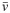
Fitted parameters over the range q = 0-0.4 μm−1.(a) Mean v¯ and (b) width σ of the fitted Schultz swimming speed distribution, (c) proportion of motile cells α, (d) head amplitude A0, (e) head frequency f0 and (f) diffusion coefficient of the non-motile spermatozoa Dnm. (○) Fresh ejaculate diluted to ∼ 20 × 106 cells/ml and recorded using (2.5×, 100 fps, 480 p, 40 s). These parameters correspond to the data in Fig 4. (□) thawed semen undiluted (∼ 80 × 106 cells/ml) and recorded using (2×, 300 fps, 300 p, 40 s). (△) thawed semen diluted 4× to ∼ 20 × 106 cells/ml recorded using (2×, 1000 fps, 300 p, 8 s).